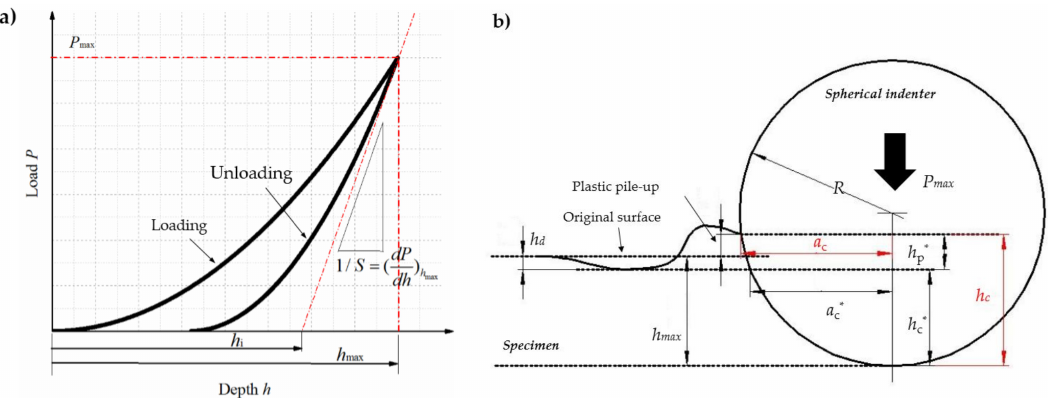
Figure 2. The typical load–depth curve and indentation morphology by spherical indenter: ( a ) the typical load–depth curve; ( b ) the typical indentation morphology by spherical indenter for